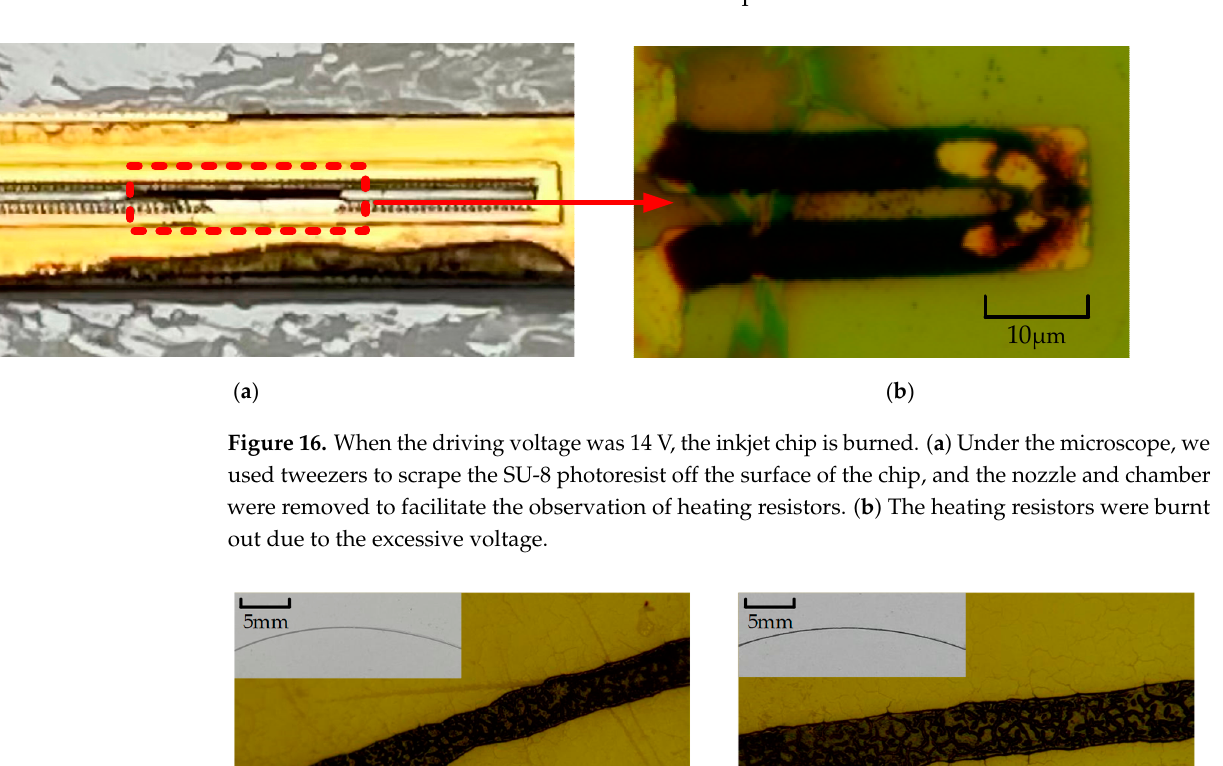
Figure 17. Reducing the speed of motor, using the different voltages to drive the inkjet chip and observe the ink-mark lines. ( a ) The printing path of the inkjet chip when the driving voltage was 10 V. ( b ) The printing path of the inkjet chip when the driving voltage is 12 V.